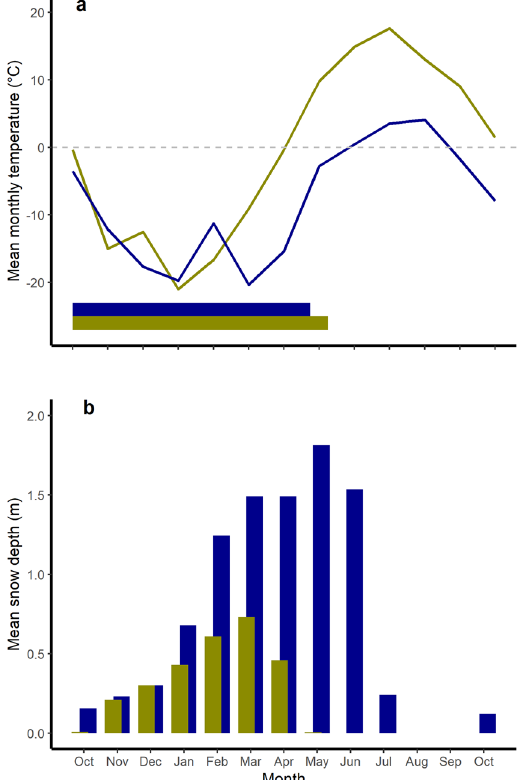
Figure 1. Ambient climatic conditions during the study period (October 2017 to October 2018) at Zackenberg, Greenland (wild population; blue) and Fairbanks, Alaska (captive population; yellow), with ( a ) showing the mean monthly air temperature and ( b ) showing the mean monthly snow depths at two sites. Horizontal bars in ( a ) indicate the approximate gestation period for muskoxen at the two sites. Temperature for Zackenberg were available from Greenland Ecosystem Monitoring (http://data.g-e-m.dk) and for Fairbanks from https://www. usclimatedata.com. Snow depth data were obtained from GeoBasis Zackenberg and for Fairbanks from https:// w2.weather.gov/climate/index.php?wfo =